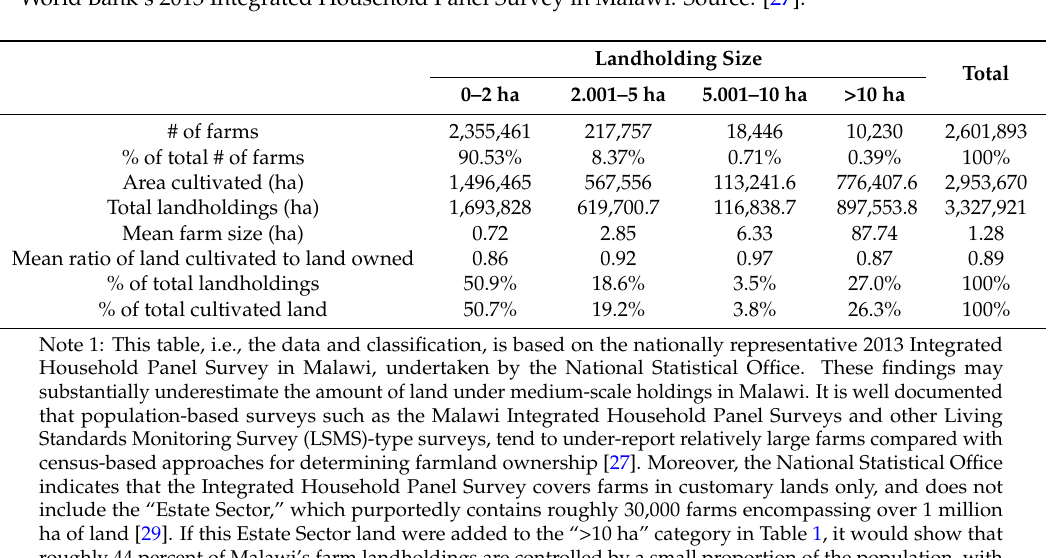
Table 2. Distribution of landholdings and cultivated area by farm size in Malawi, according to the World Bank’s 2013 Integrated Household Panel Survey in Malawi. Source: